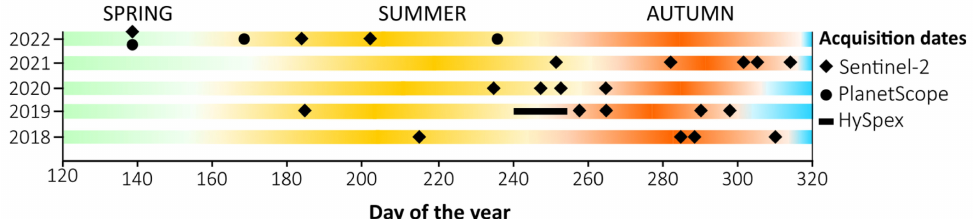
Figure 2. Broadleaf ( A ) and coniferous ( B ) forest stands in the Tatra Mountains. Photo credit: M. Kluczek, 2022.